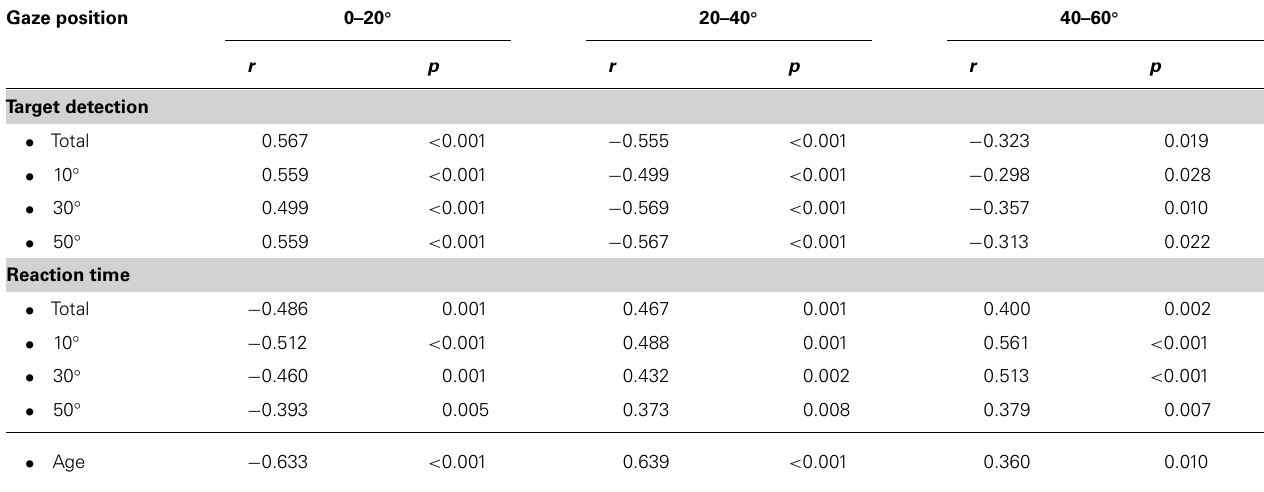
Table 4 | Correlations between target detection performance/reaction time/age and gaze position. Gaze position